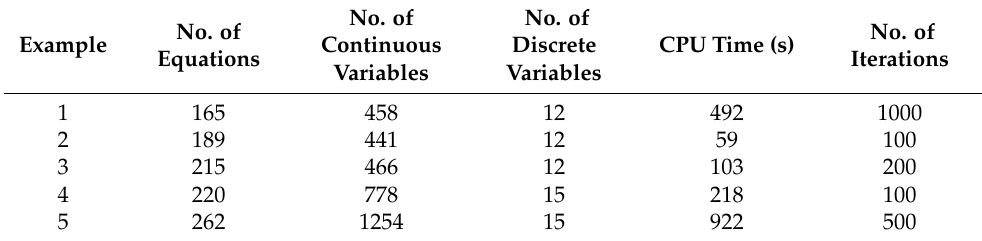
Table 11. Model statistics for the studied